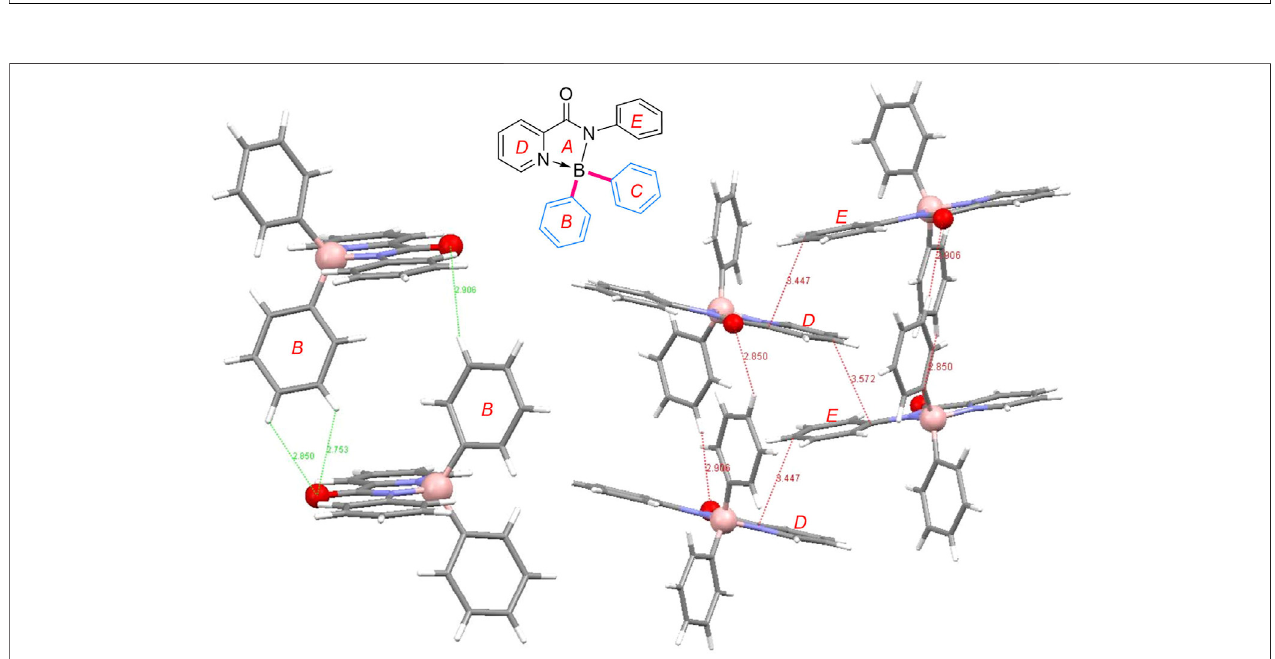
FIGURE3| AIE behaviours of 3a . (A) 3a solidat 365 nm. (B) Fluorescence comparison of 3a solution at 365 nm at differenttime. (C) Fluorescence comparison of 3a at 365 nm in different ratios of water/methanol.